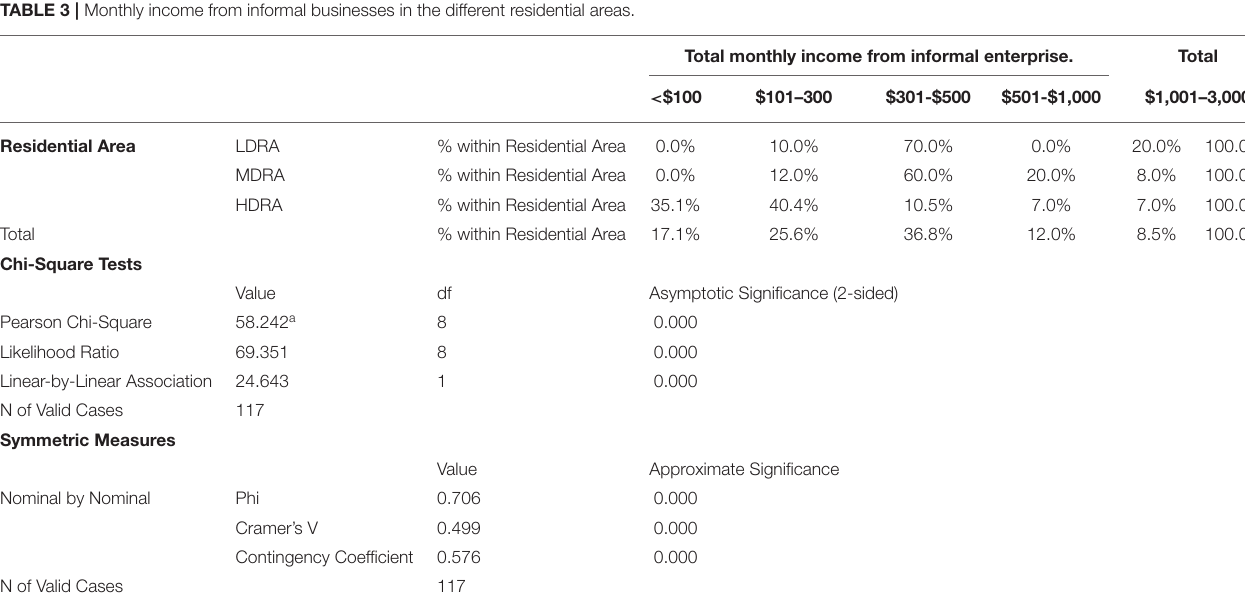
TABLE 3 | Monthly income from informal businesses in the different residential areas.